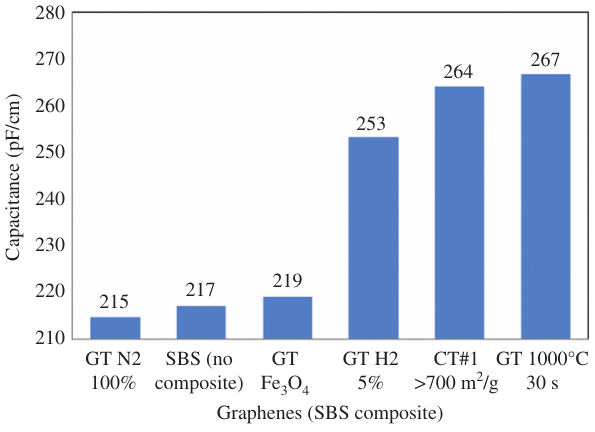
Figure 10 Capacitance versus SBS-graphene composites (meas- ured at 11 kHz